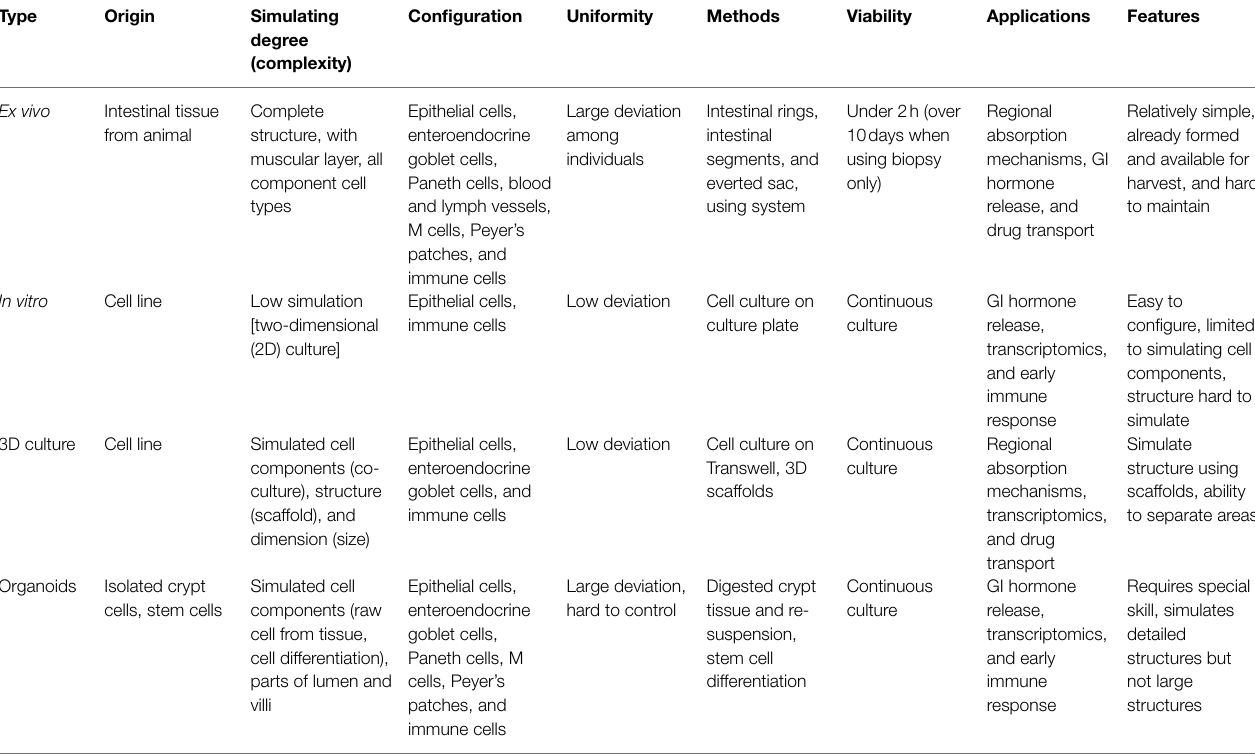
TABLE 1 | Types of intestine models and their